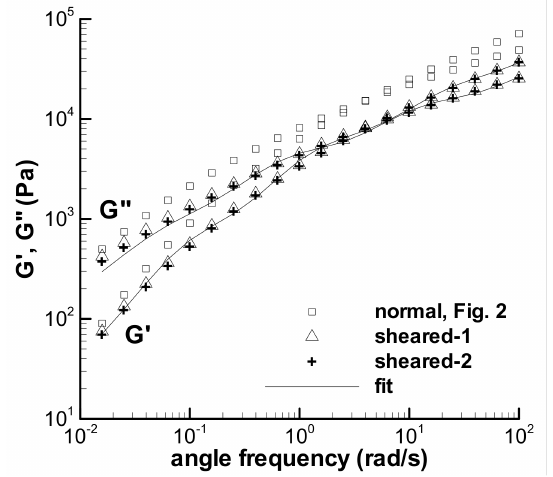
Figure 15. Dynamic frequency sweep experiments at = 5% for the LDPE melt at 150 ◦ C, which are obtained after the time sweeps at the large strain in Figure 14, and the fit on the frequency sweep